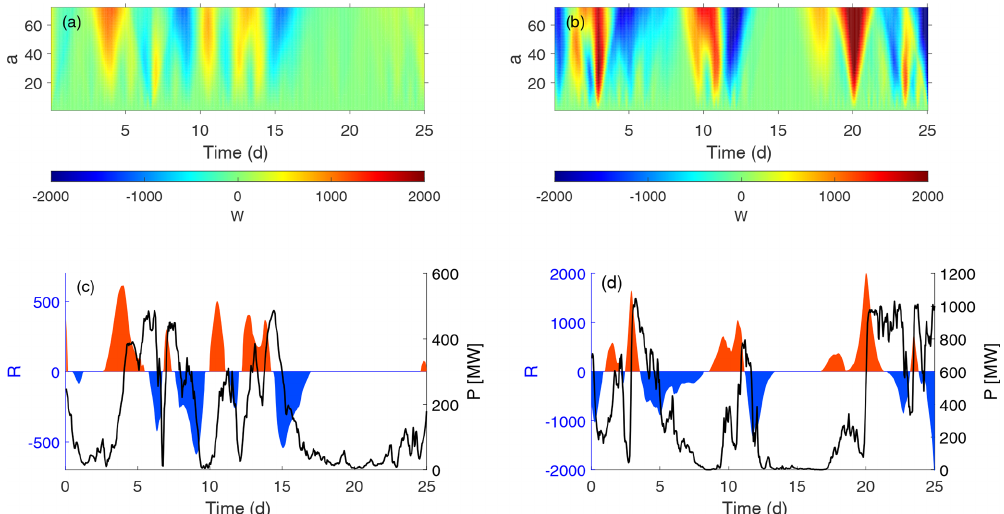
Figure 10. Wavelet coefficients and ramps based on wind power for the aggregated Swedish energy price region SE1 for two periods, 1 to 25 January 2000 and 6 to 31 December 2001; (a) continuous wavelet transform coefficient for the period 1 to 25 January 2000; (b) continuous wavelet transform coefficient for the period 6 to 31 December 2001; (c) power ramps for the period 1 to 25 January 2000; and (d) power ramps for the period 6 to 31 December 2001. Table 2. Comparison of the wavelet-surrogate (WS) and min–max ramp detection methods. The number of ramp-up and ramp-down events are shown in bold and in parenthesis, respectively. Periods T1–T4 are given in Table 1; T5 is the Belgian offshore wind power data for the entire period 2015–2016 and SE1 is the hourly Swedish wind power data for the period 2000–2001. WS Min–max